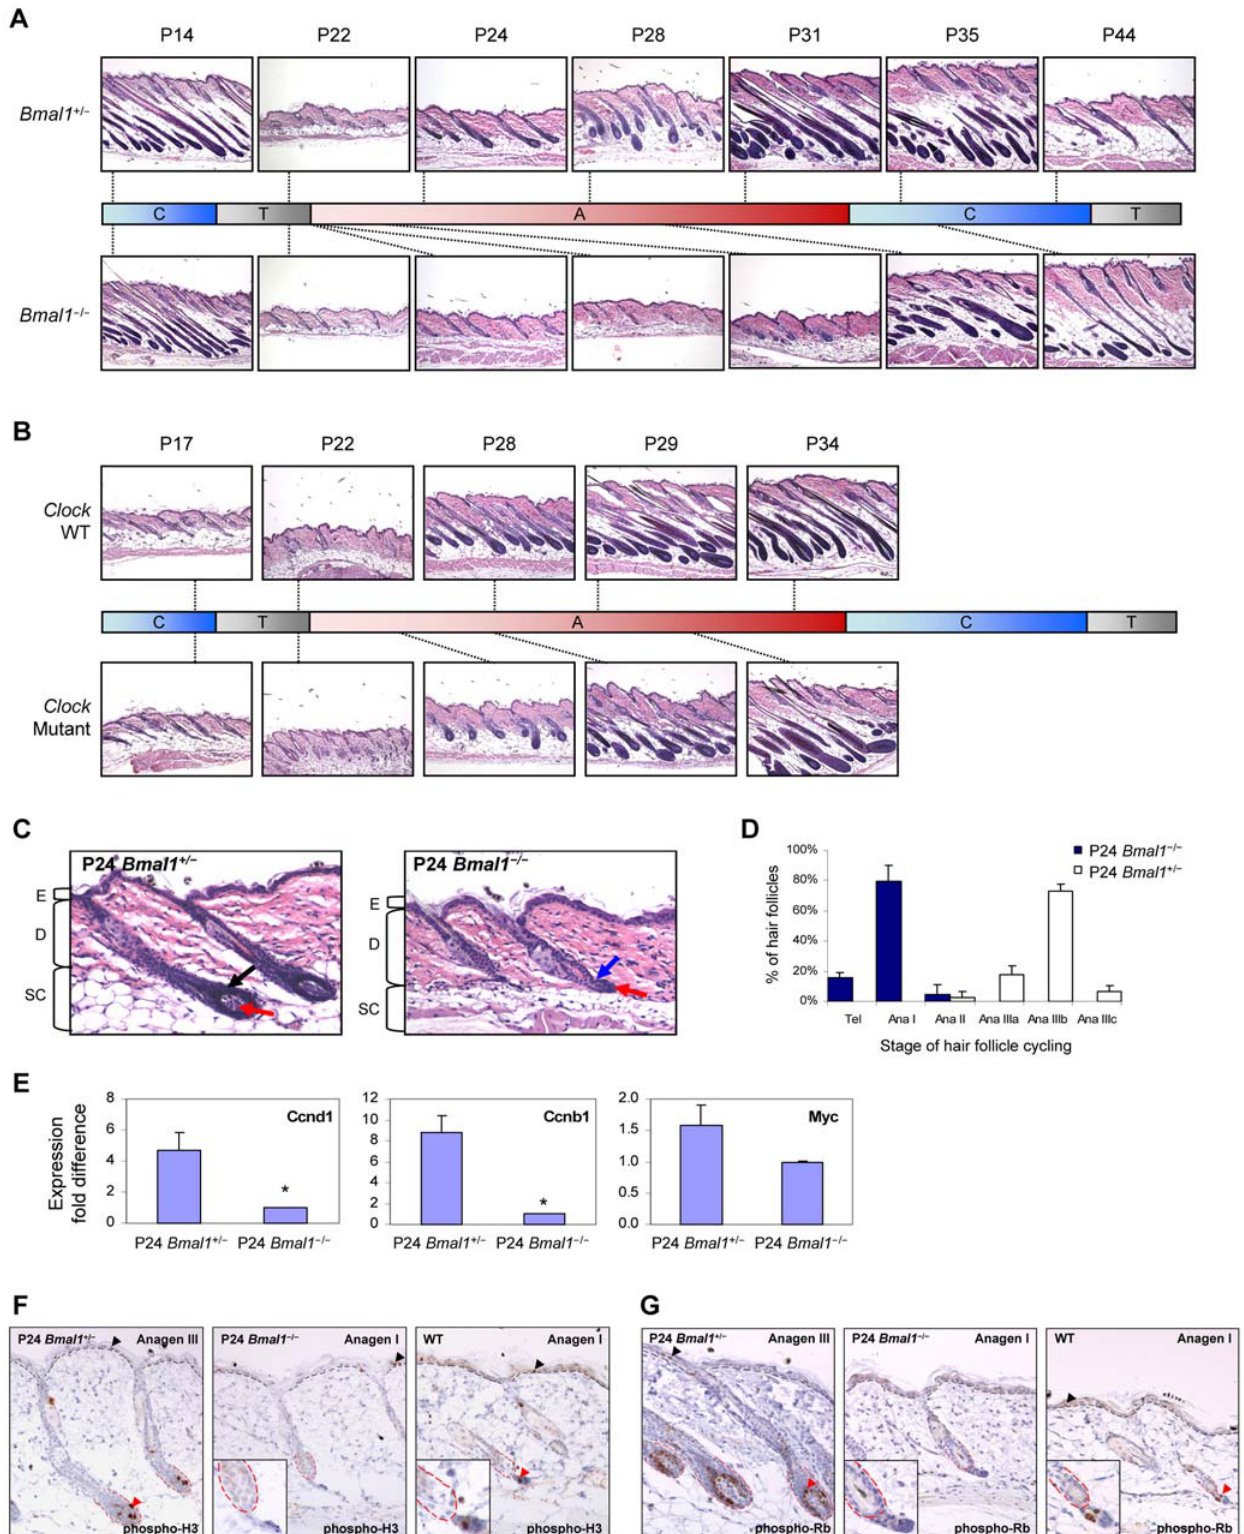
Figure 6. Bmal1 and Clock regulate anagen progression in hair follicle cycling. (A) Representative histological sections of dorsal skin from Bmal1 2 / 2 mice and their gender-matched Bmal1 + / 2 littermates at the indicated postnatal age (P). (B) Representative histological sections of dorsal skin from Clock mutant and their gender-matched wild-type (WT) littermates at the indicated postnatal age (P). For (A) and (B), time points are mapped (indicated by dotted line) based on histology to the corresponding phases of the hair growth cycle: anagen (A), catagen (C), and telogen (T). (C) Delayed anagen progression in Bmal1 2 / 2 mice compared to normal progression in Bmal1 + / 2 littermates. At postnatal day 24, hair follicles are in